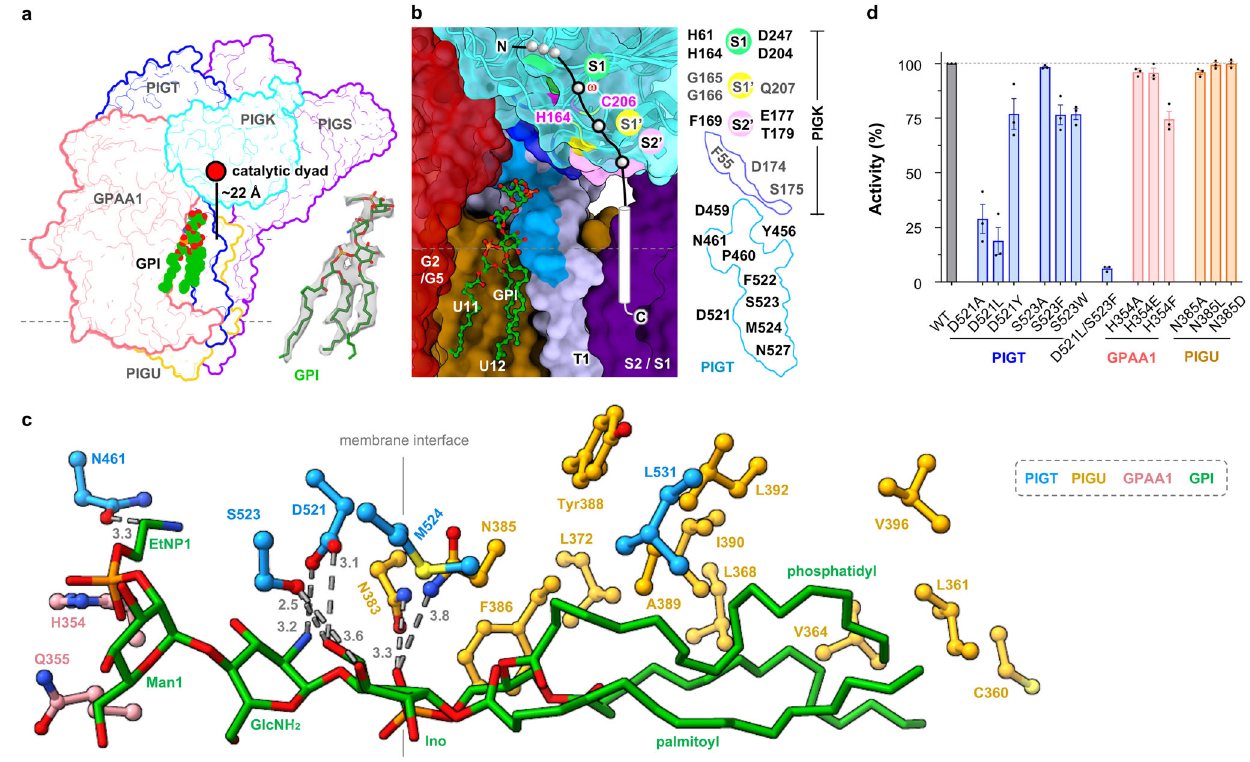
Fig. 3 Characterization of a composite GPI-binding site. a Cryo-EM density that fi lls a nearly complete GPI was observed in the membrane cavity “ underneath ” the catalytic dyad. b Expanded view of the composite site encompassed by the indicated TMHs from GPAA1 (G) /PIGU (U) /PIGT (T) /PIGS (S). Evolutionarily conserved residues (Supplementary Fig. 6c, d) in the vicinity are colored marine (PIGT) and blue (PIGK). Subunits are shown as surfaces except that PIGK was additionally shown as ribbon representations with the catalytic dyad and S1/S1 ′ /S2 ′ residues highlighted in indicated colors. c Interaction between the partial GPI (green) and GPI-T (colored-coded as indicated). Distances (Å) are either indicated by numbers for H-bonding interactions or omitted for hydrophobic interactions (within 5 Å of GPI). A vertical line marks the membrane boundary. Although the major form of the phosphatidyl moiety in mammal cells contains 1-alkyl-2-acyl-glycerol, a diacylglycerol was modeled based on the density. d Apparent activity of GPI-T mutants relative to the wild-type (WT). GPI-T KO cells were gated by TGP fl uorescence 41 for subunit expression and analyzed for surface staining of the reporter GPI-AP (CD59) by fl ow cytometry. Bar graph is color-coded to match the coloring for subunits in ( b ). Data represent mean ± s.e.m. from three independent experiments. Source data are